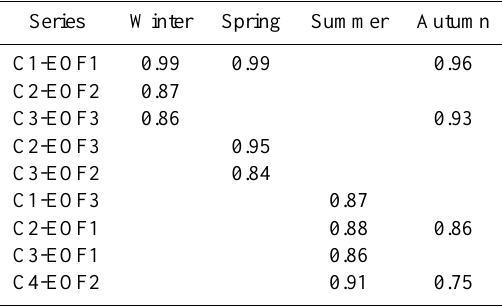
Table 3. Correlation coefficients between centroid time series and principal component time